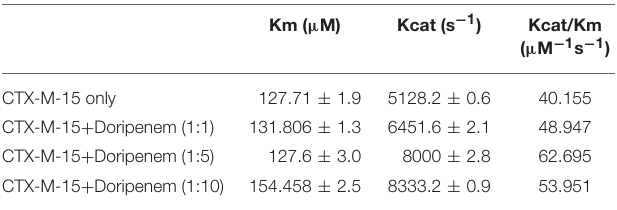
TABLE 4 | Steady-State kinetic parameters for hydrolysis activity of CTX-M-15 in presence of